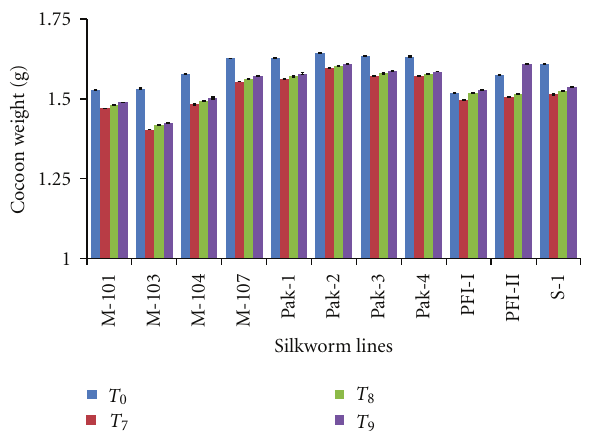
Figure 4: Comparative performance of cocoon shell weight of (mean ± SE) eleven silkworm lines at 25 ± 1 ◦ C in combination with 5, 65, and 75% RH and controlled conditions of temperature and RH (25 ± 1 ◦ C and 70–80%, resp.).